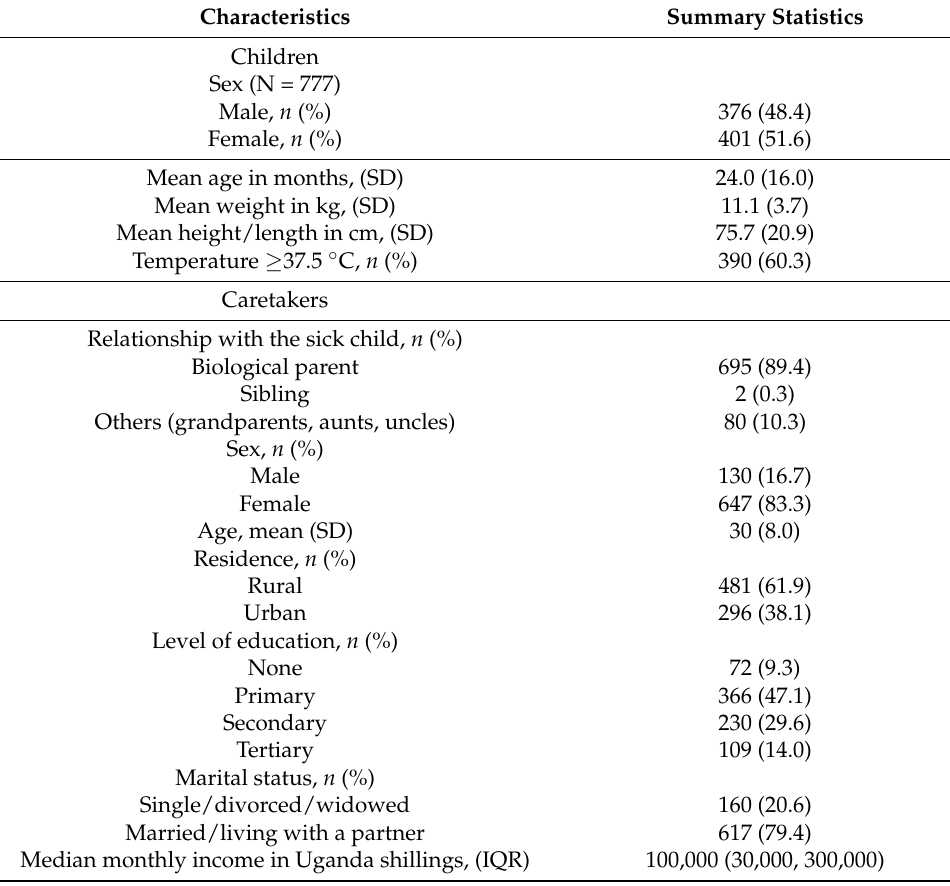
Figure 3. Clinical problems at presentation among children seeking medical care in low level private health facilities in Mbarara Uganda. Table 3. Characteristics of the children and their